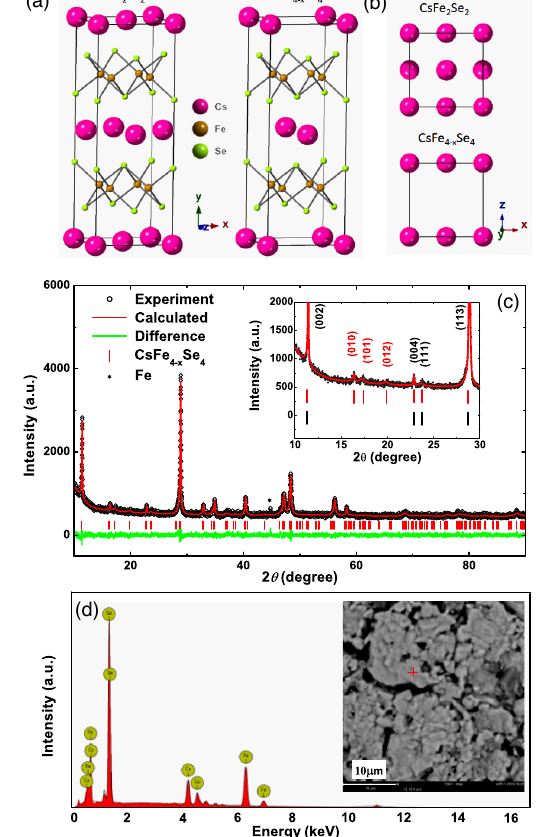
FIG. 1. Structure and compositional analysis of CsFe 4 − x Se 4 . (a) Schematic crystal structure of CsFe 2 Se 2 and CsFe 4 − x Se 4 . (b) Crystal structure of CsFe 2 Se 2 (restructured) and CsFe 4 − x Se 4 viewed along the [001] direction. (c) X-ray-diffraction pattern for polycrystalline CsFe 4 − x Se 4 with the Rietveld refinement. The inset in panel (c) shows typical peaks of CsFe 4 − x Se 4 , marked with red indices. The black vertical lines show the coincident indices of CsFe 2 Se 2 and CsFe 4 − x Se 4 . (d) Typical energy dispersive spectrum, which shows the compositional ratio of the measured spot. The averaged composition of Cs ∶ Fe ∶ Se ¼ 1 . 2 ∶ 3 . 95 ∶ 4 was obtained by the measurements at 19 spots and areas. The inset shows a scanning electron micrograph image.